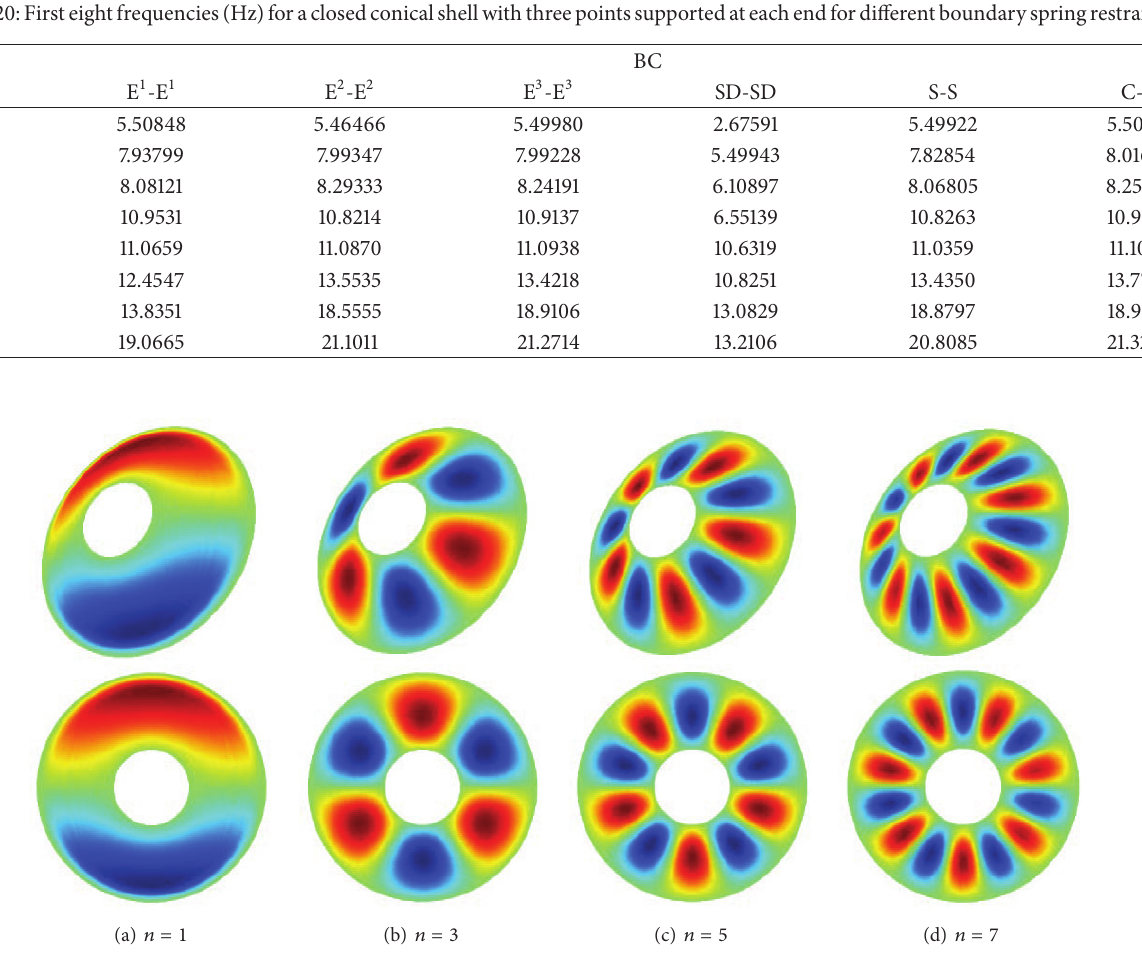
Figure 11: Some selected mode shapes for closed conical shells with various wavenumbers 𝑛 subjected to E 3 -E 3 boundary conditions (𝑚 = 1) .